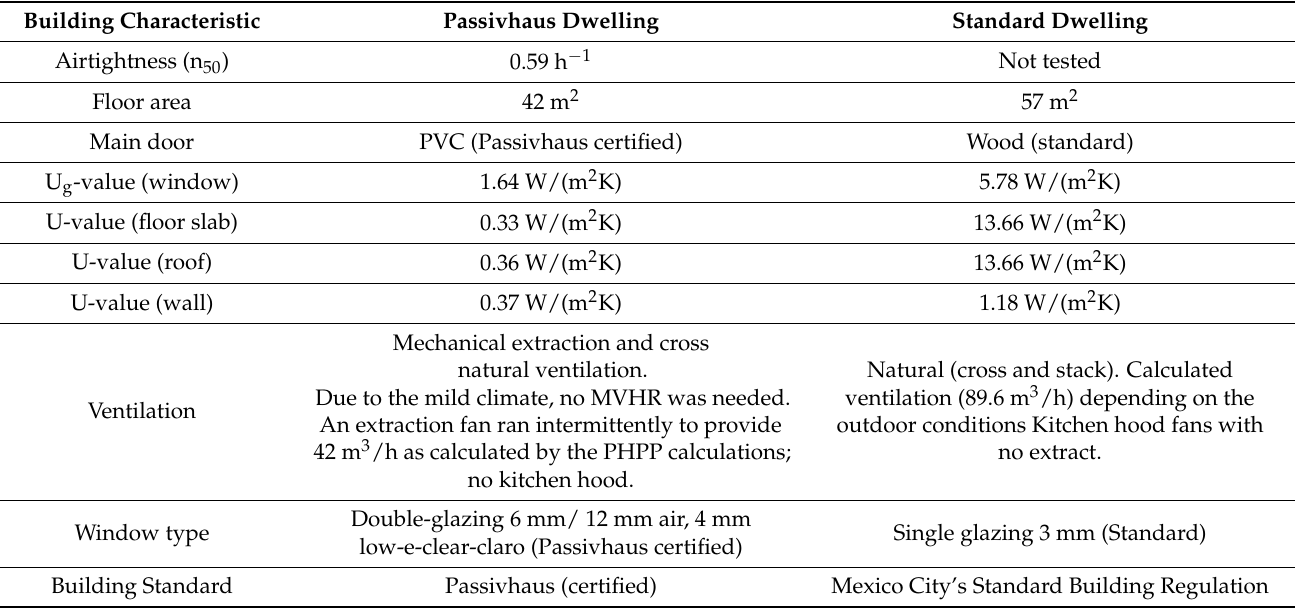
Table 2. Main building characteristics of the Passivhaus and Standard Dwellings. Source: